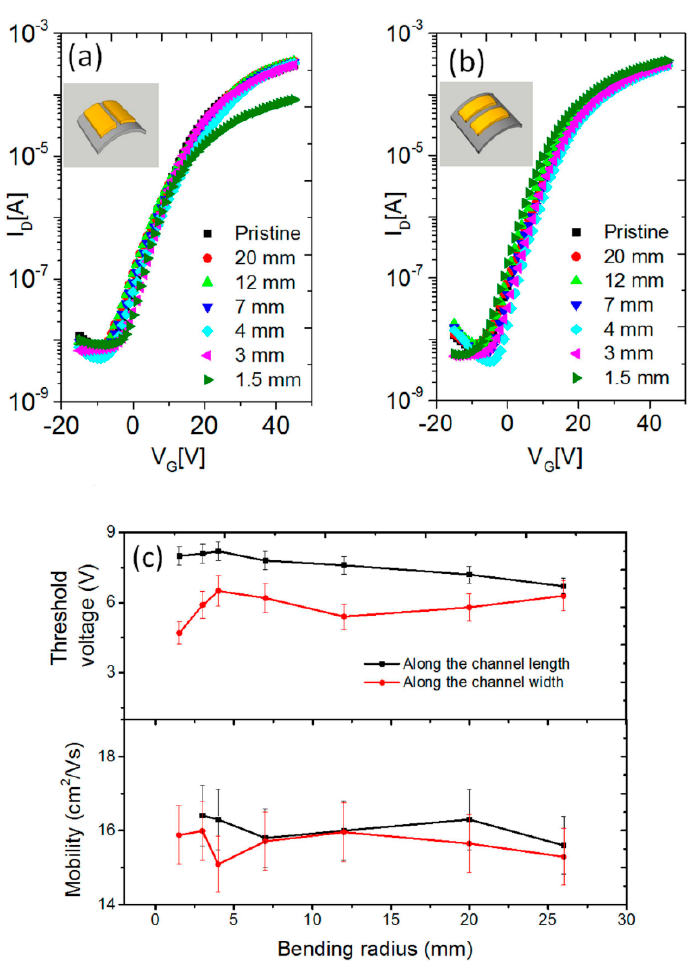
Figure 12. Two kinds of bending behaviors of IGZO TFTs and their transfer curves; ( a ) bending along channel width and ( b ) along the channel length at various bending radius. ( c ) The extracted, mobility and threshold voltage at various bending radius [160].